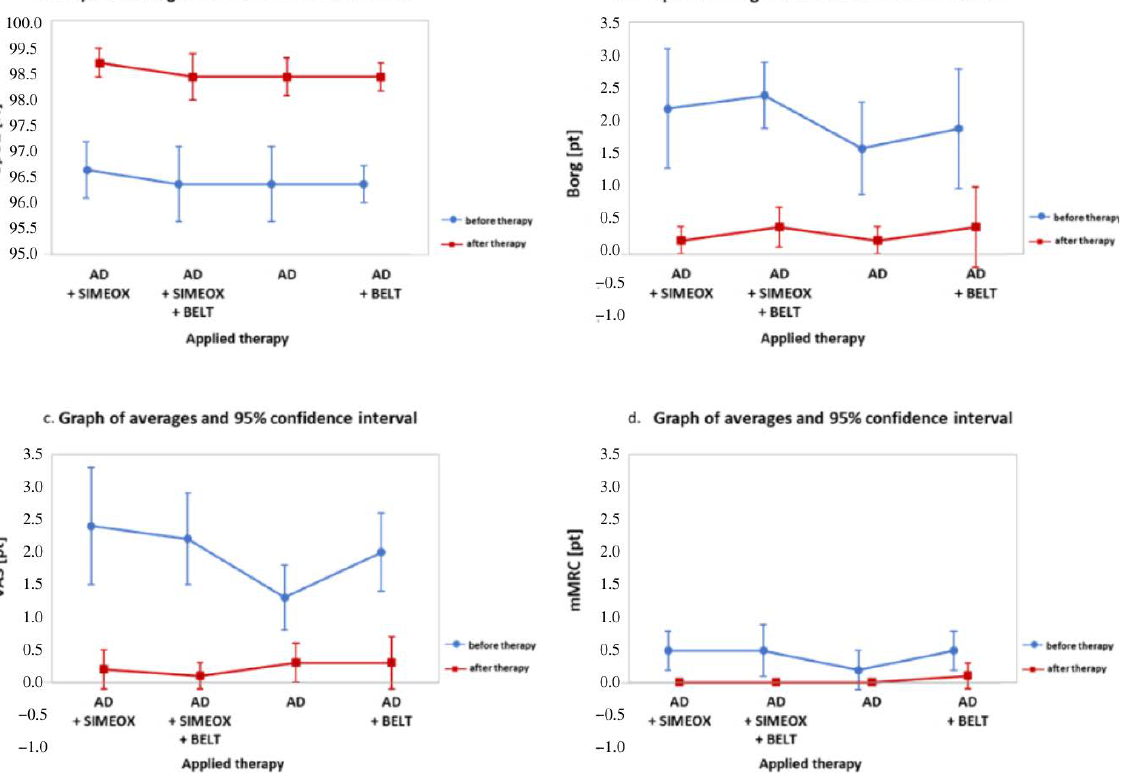
Figure 2. Graphic representation of pre- and post-therapy results for: ( a ) percent blood oxygen saturation (SpO2); ( b ) the Borg Rating of Perceived Exertion Scale (Borg); ( c ) the Visual Analogue Scale (VAS); and ( d ) the modified Medical Research Council (mMRC) dyspnea scale. AD, autogenic drainage .